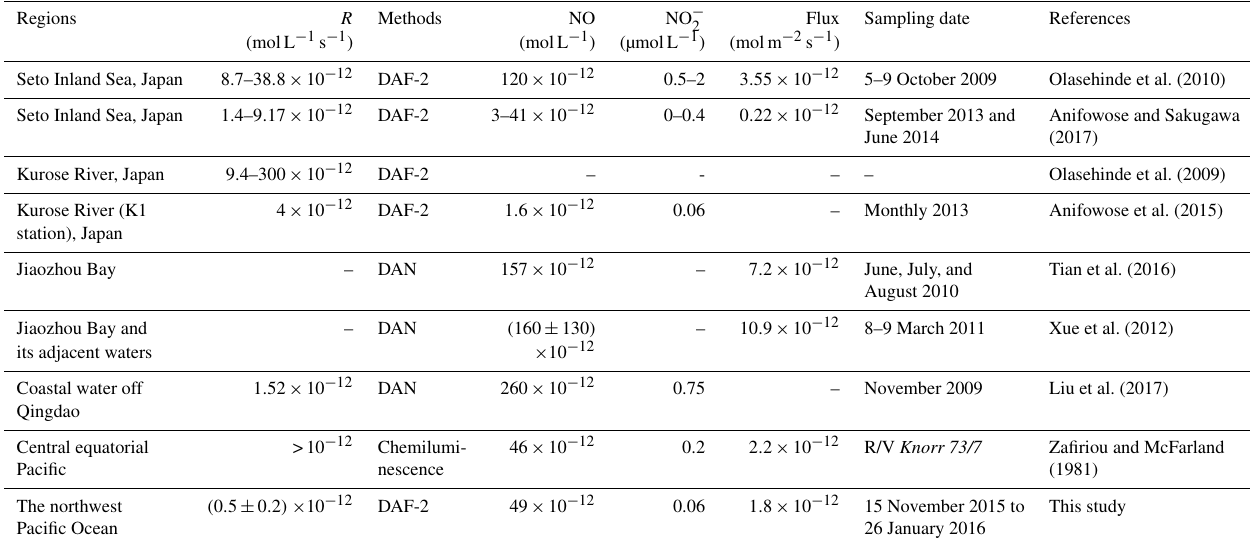
concentrations, and average flux densities of NO in different 2